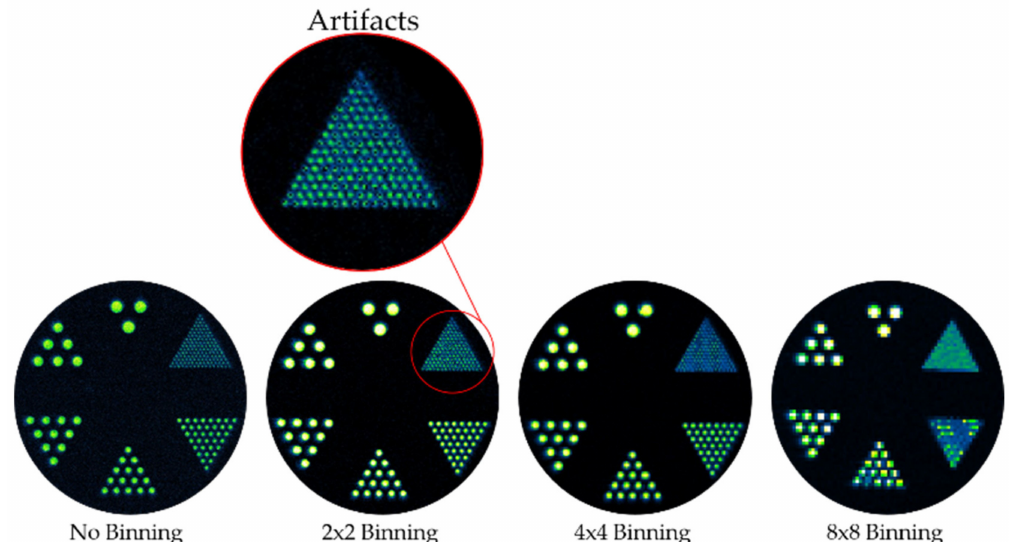
Figure 4. Optical imaging of Derenzo-style optical imaging phantom with varied CCD bin states. In the 2 × 2 binning setting, dead pixel artifacts were present, as highlighted in